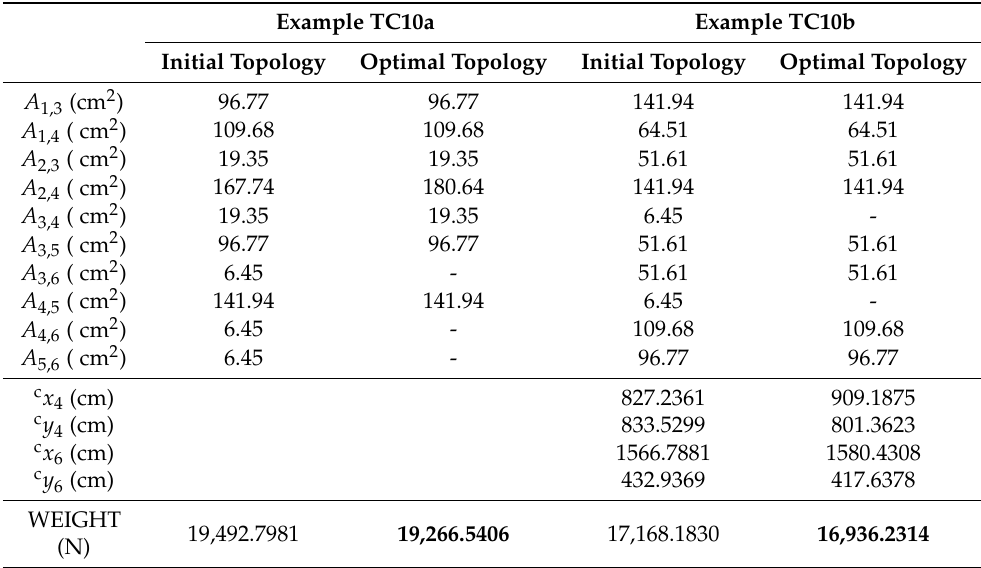
Table 6. Optimal results, examples without buckling constraints TC10a (topology optimization) and TC10b (topology and shape